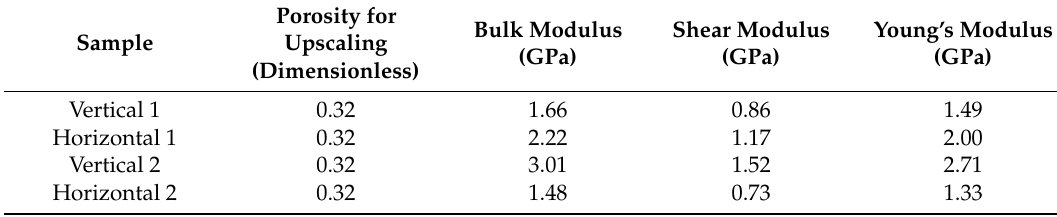
Figure 8. Upscaling of modulus at macroscale for representative sample vertical 1. Table 4. Upscaling results of four samples using differential effective medium